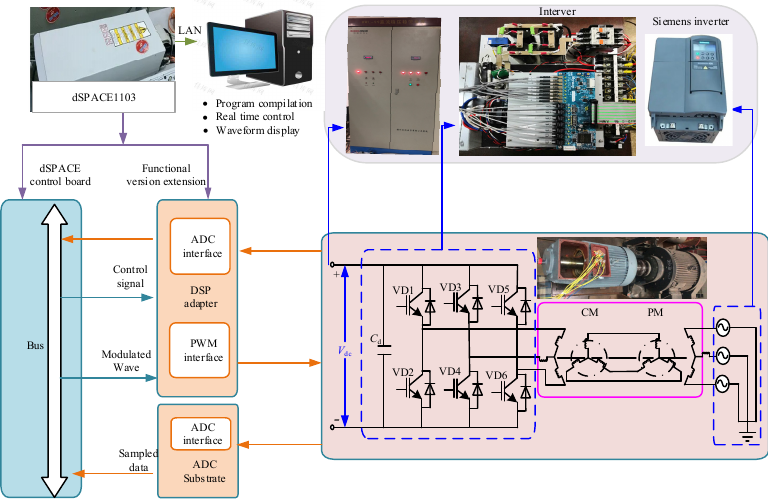
Figure 16. Hardware experimental platform connection diagram.